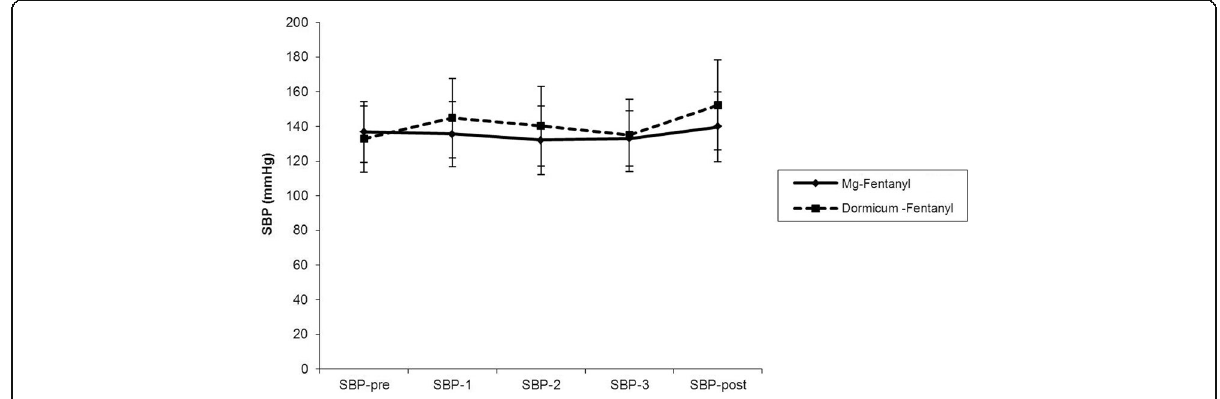
Fig. 2 Changes in systolic blood pressure (SBP) in both study groups. Markers represent means and error bars represent 95% CI